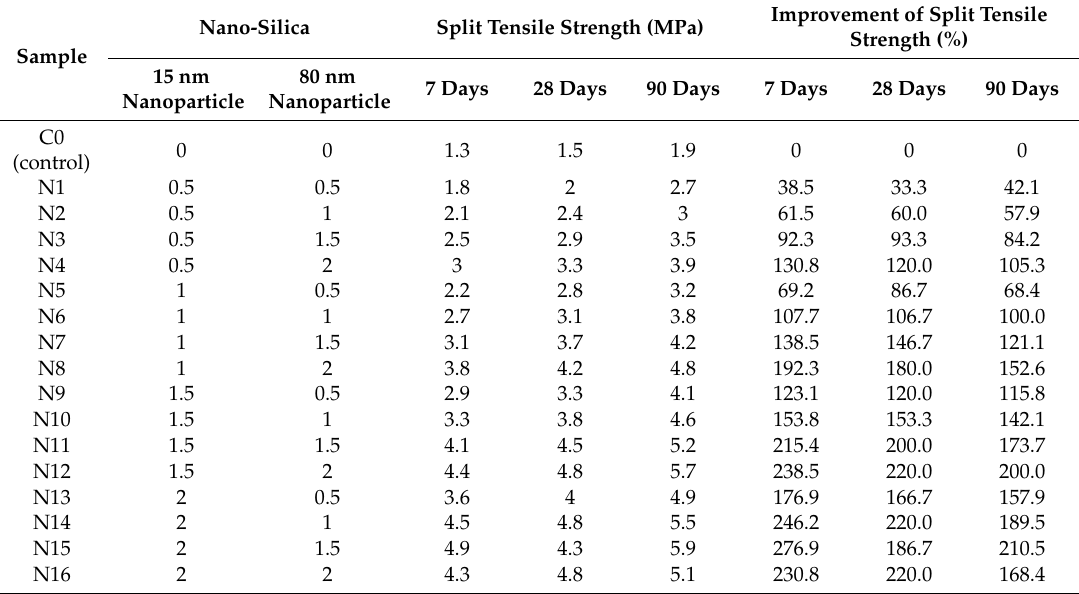
Table 2. Split tensile strength of concrete specimens containing several nano-silica contents. Reprinted with permission from [86]. Copyright © 2019, Elsevier B.V.